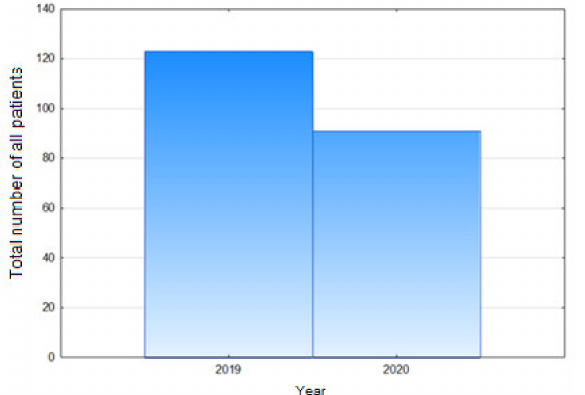
Figure 1. Total number of all patients—hip endoprosthesis.